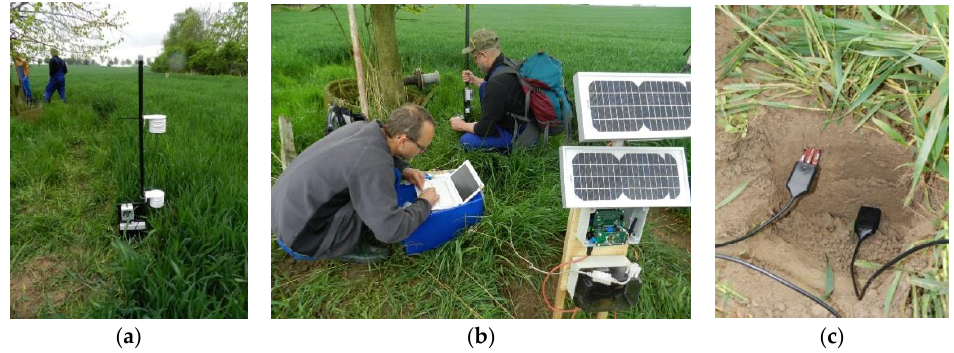
Figure 1. Sensor installations in various conditions: ( a ) field sensors in a field with winter wheat; ( b ) installation of a WSN gateway; ( c ) detailed installation of soil moisture sensors in the soil profile. Table 1. Node sensors and meteorological sensors used for verification of the wireless sensor network on farm land Node Sensors/Meteorological Stations shield at the height of the canopy stand or above.